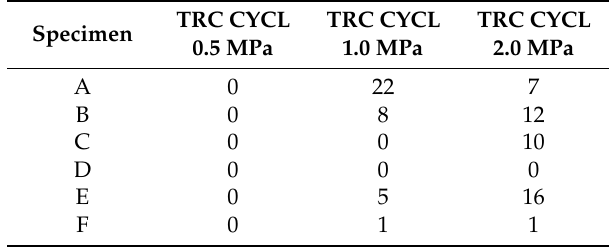
Table 5. Number of cracks formed during cyclic preloading of the TRC coupons.